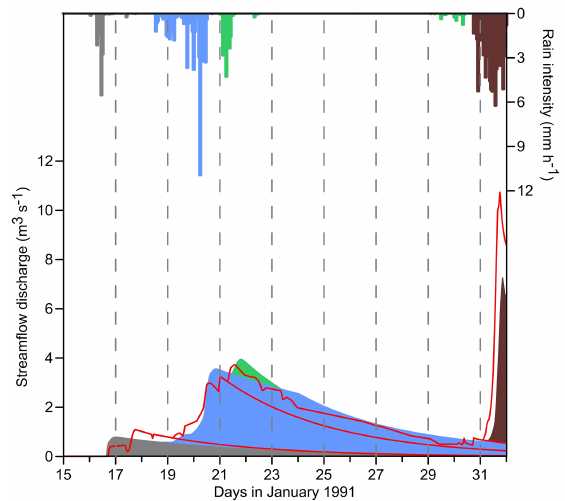
Figure 4. An example of rainfall and streamflow discharge from the upper Dalya catchment separated into different events of rain- fall and streamflow. Red line represents the observed hydrograph obtained from the hydrometric station and filled areas represent the hydrograph simulated by the SAC-SMA. See text for details about the separation procedure for rain and streamflow